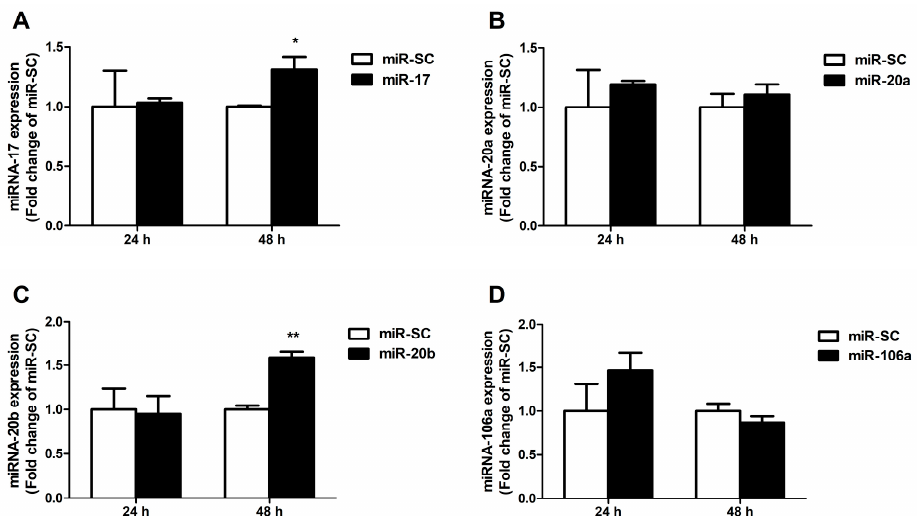
Figure 4. Expression of the selected miRNAs in Caco-2 cells. ( A ) The results of a quantitative RT-PCR analysis of the miR-17 expression level in Caco-2 cells transfected for 24 h and 48 h. ( B–D ) The levels of the miR-20a, miR-20b and miR-106a in Caco-2 cells were measured by qRT-PCR at 24 h and 48 h after transfection. Values were expressed as means ± SEM, n = 3 in each group, * p < 0.05, ** p < 0.01.